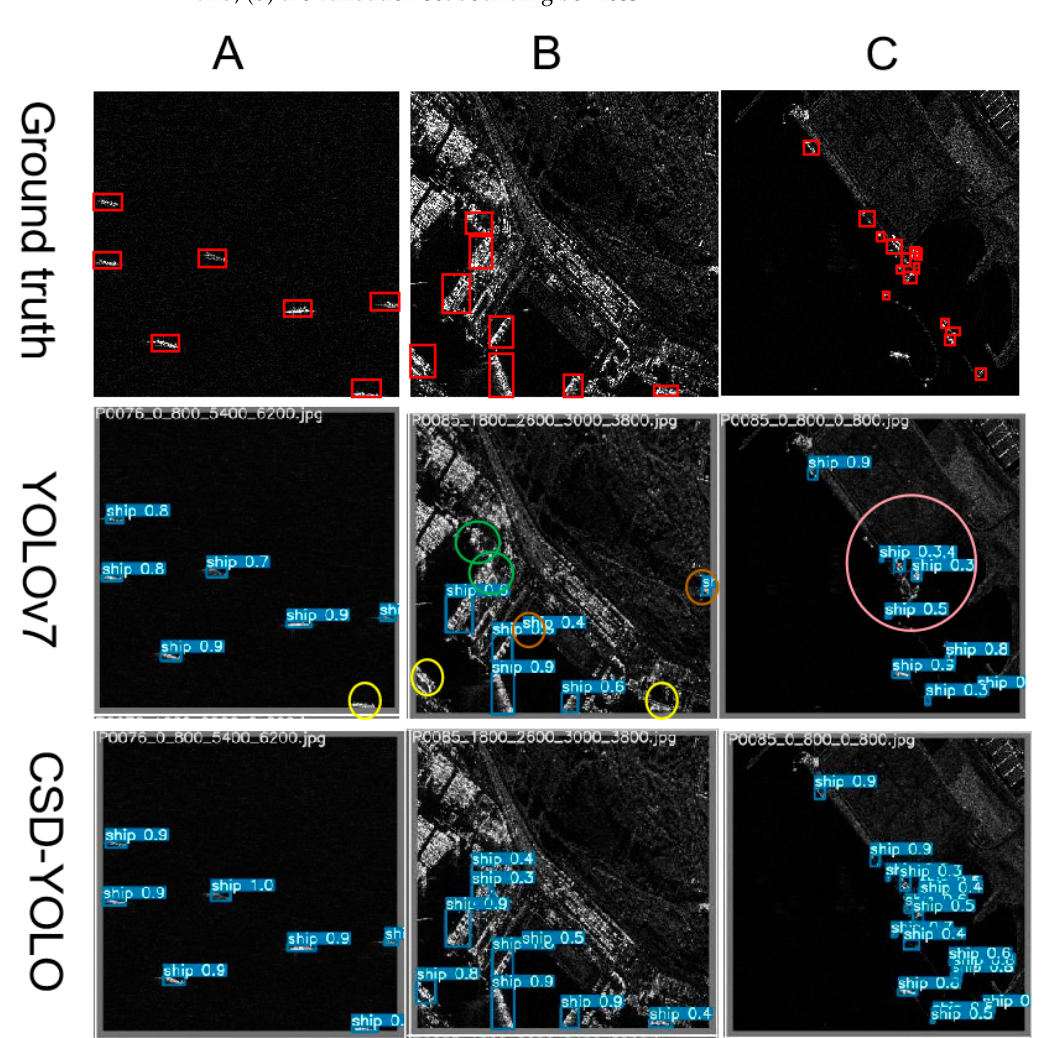
Figure 10. Detection results of YOLOv7 and CSD-YOLO.